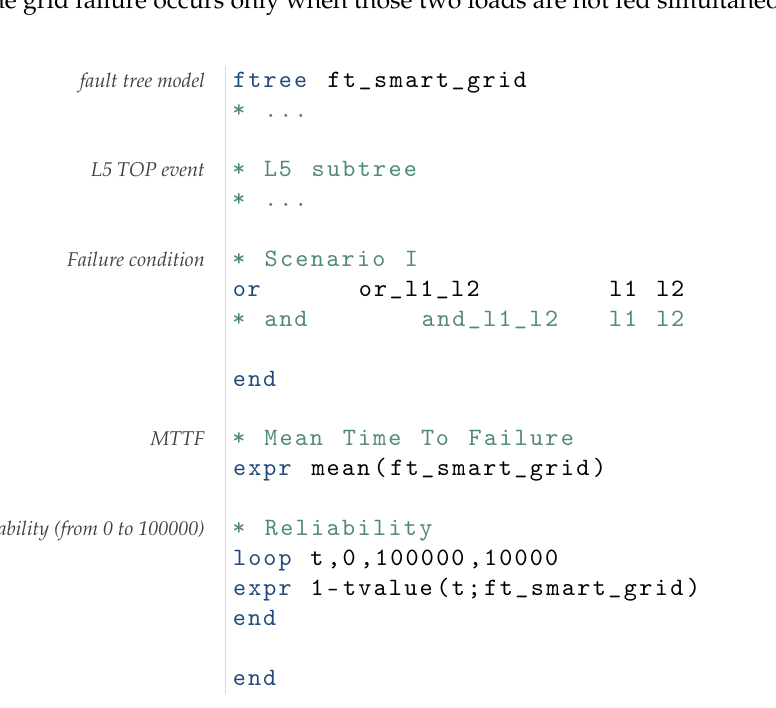
Figure 12. Failure conditions and evaluation metrics for scenario I ( SHARPE